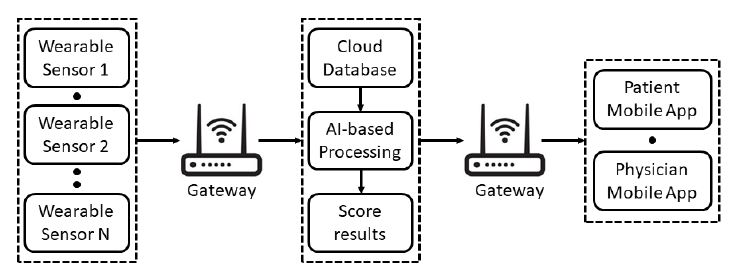
Figure 1. General architecture of the proposed soft